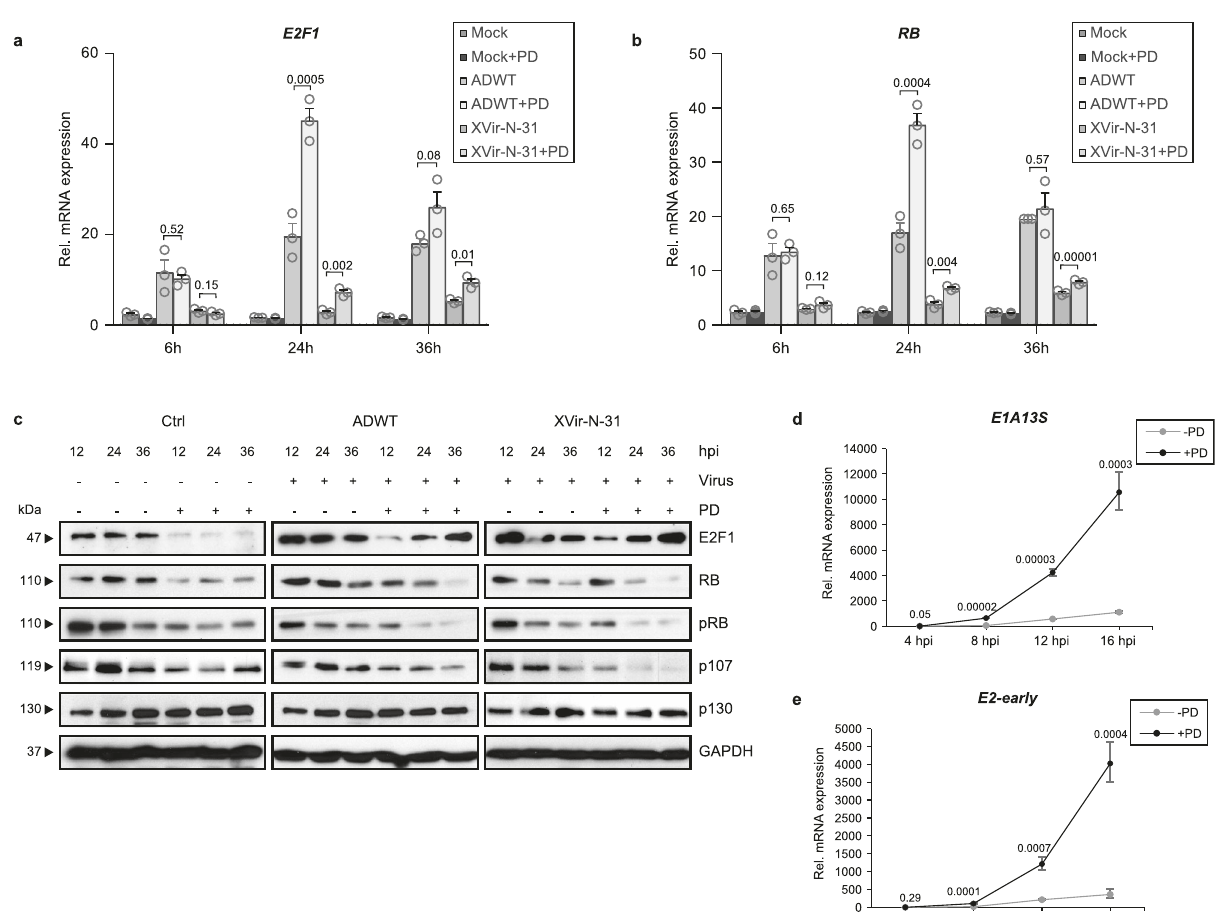
Fig. 4 | The modulation of RB – E2F protein complex by CDK4/6i is responsible for enhanced viral genome replication. T24 cells were pre-treated for 24h with 0.5 µ MPalbociclibandinfectedwithADWTorXVir-N-31(MOI50). a , b Cellulargene expressionwasanalyzedbyqRT-PCRatindicatedtimepointsforthegenesE2F1( a ) and RB ( b ). Data are presented as relative mRNA expression compared to the housekeepinggenebeta-actin( n =3,mean±SD). c Proteinexpressionwasanalyzed at indicated time points by western blotting. One representative blot is shown in